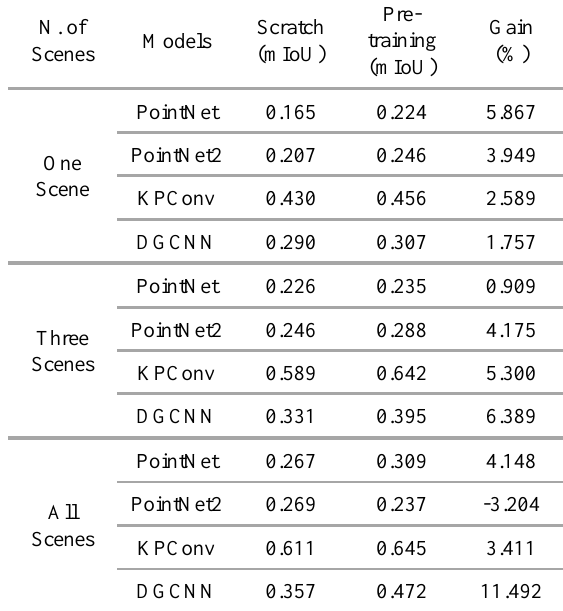
Table 2. Comparing two pipelines while utilising distinct deep learning (DL) pipelines and various subsets of training data, using the ArCH Dataset as a benchmark. “N. of Scenes” denotes the used scenes in the DL training stage.